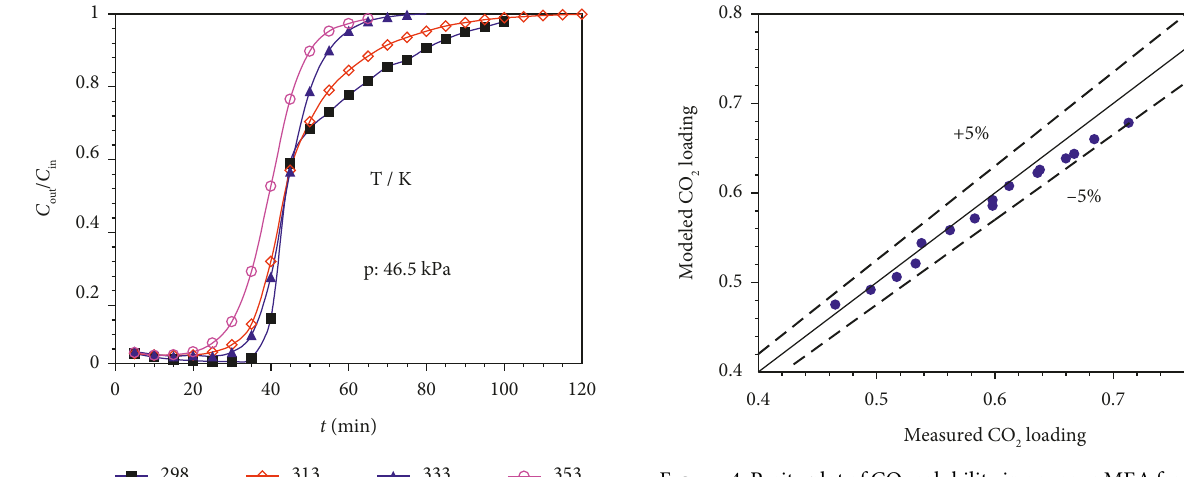
Figure 4: Parity plot of CO 2 solubility in aqueous MEA from 298 to 353K obtained from experimental measurement and modified Kent-Eisenberg model